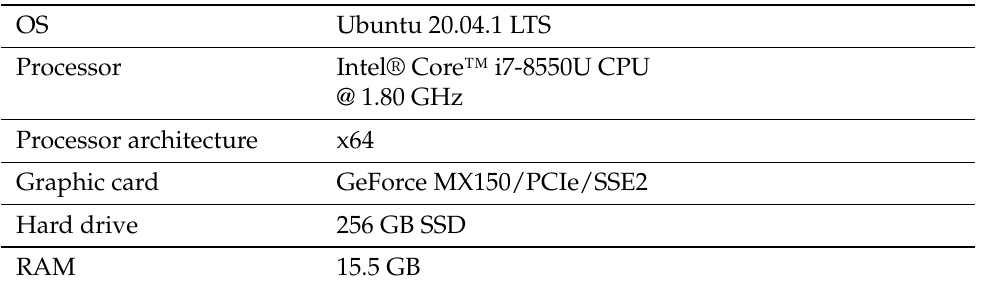
Table 1. Testing Machine